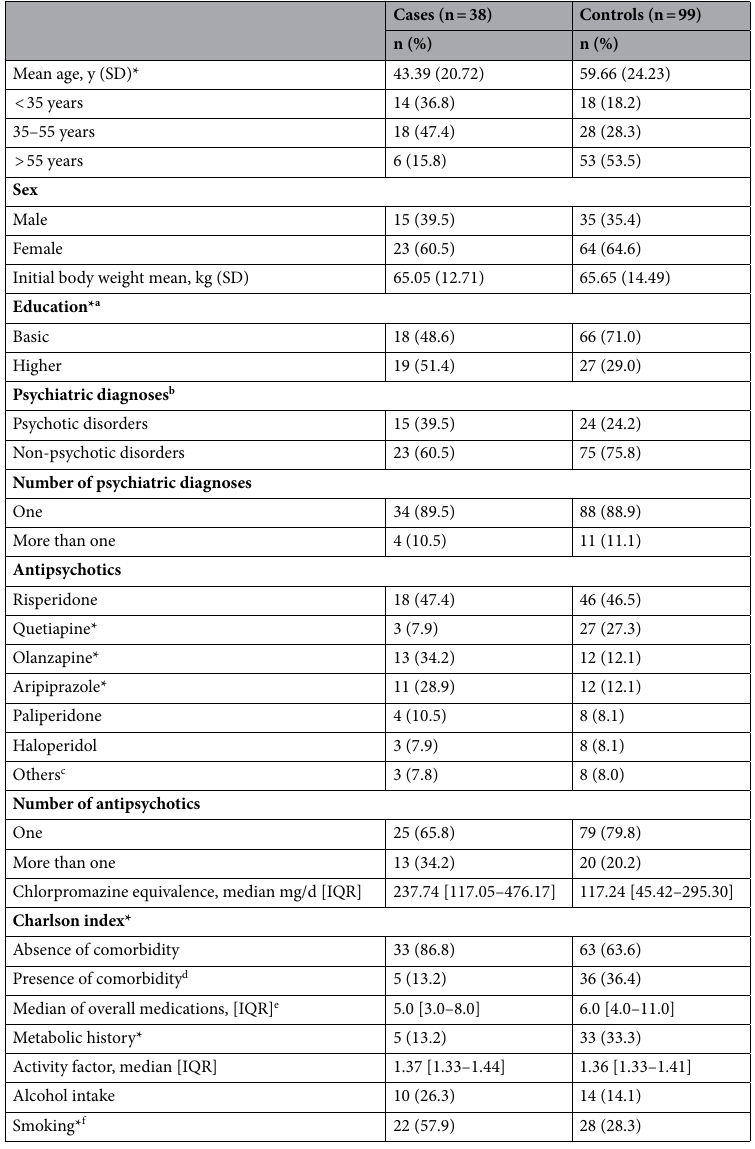
Table 1. Distribution of the main characteristics in the two groups in comparison. * p < 0.05. a No data, 7 patients (1 case, 6 controls); Basic education: reading and writing, primary and secondary education. b Psychiatric diagnoses were made by medical specialists. Psychotic disorders cover schizophrenia, schizotypal, delusional, and other non-mood psychotic disorders (F20 to F29 codes). Non-psychotic disorders cover mental disorders due to known physiological conditions (F00 to F09 codes), mental and behavioral disorders due to psychoactive substance use (F10 to F19 codes), mood [affective] disorders (F30 to F39 codes) and other mental disorders (F40 to F99 codes), according to the International Classification of Diseases, 10th edition. c Amisulpride, asenapine, sulpiride, tiapride, ziprasidone. d Include both low and high comorbidity. e Medications influencing somehow weight gain were metformin (cases, 0; controls, 5), levothyroxine (cases, 3; controls, 6), topiramate (cases, 3; controls, 5), digoxin (cases, 1; controls, 2) and methylphenidate (cases, 0; controls, 2). Information for these drugs is provided in the Summary of Product Characteristics. f No tobacco abstinence cases were